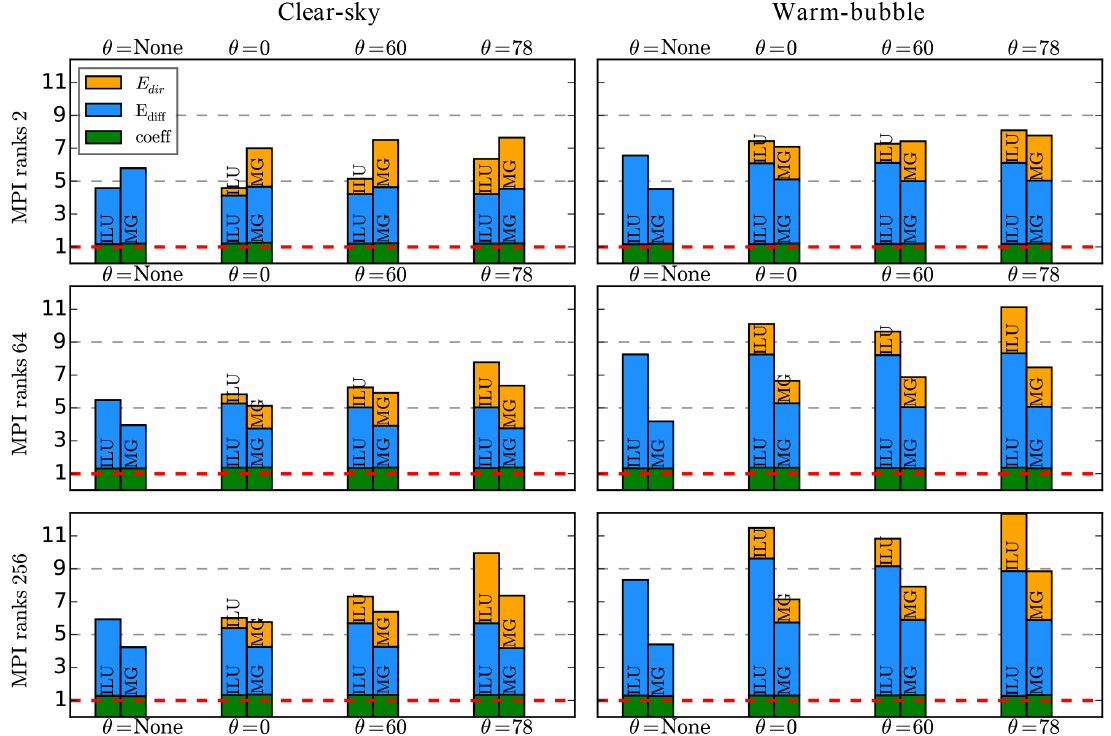
Figure 3. Two strong-scaling tests for a clear sky and a strongly forced scenario. Vertical axis is the increase of computational time normalized to a delta-Eddington two-stream calculation (solvers only). Horizontal axis is for different solar zenith angles ( θ = None means thermal only, no solar radiation). The stacked bars denoting time used for the individual components of the solver. “Coeff” is the time needed to retrieve and interpolate the transport coefficients. E diff is the elapsed time that was used to set up the source term and solve for the diffuse radiation; the same for the direct radiation in E dir . The bars are labeled with the corresponding matrix